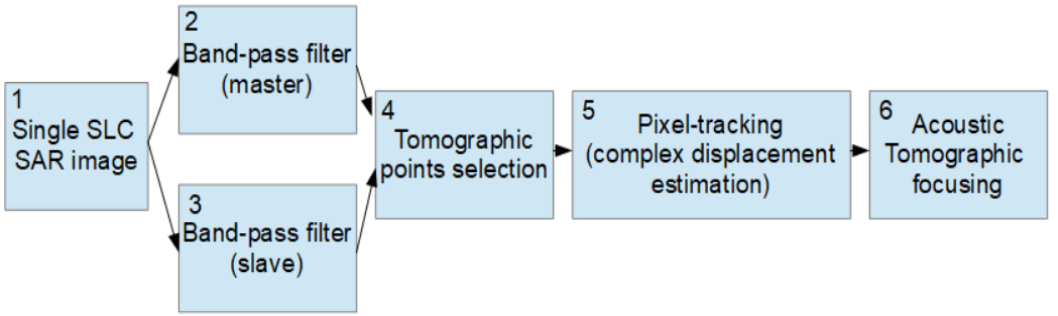
Figure 9. Computational flowchart for estimating the internal